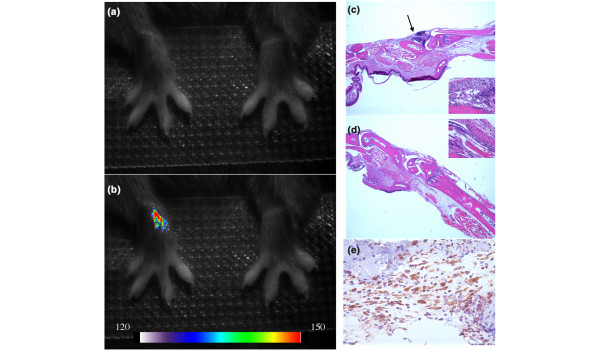
Early detection (30 hours after KRN serum transfer) of the inflammatory joint by NIR2-folate. (a) White-light image showed no remarkable swelling at bilateral paws. (b) Merged near-infrared fluorescent signal with a white-light image showed increase fluorescence signal intensity at the dorsal aspect of the right wrist, which has a 1.8-fold increase compared with the left wrist. (c) H&E-stain histology of the right wrist showed polymorphonuclear cell infiltration at the dorsal aspect of the right wrist (arrow). Magnification, 20 × (400 ×, insert). (d) Histology of the left wrist showed no remarkable inflammatory cell infiltration. Magnification, 20 × (400 ×, insert). (e) Immunohistochemistry of the right wrist showed Mac-3-positive cell infiltration at subsynovial tissues. Magnification, 400 ×.